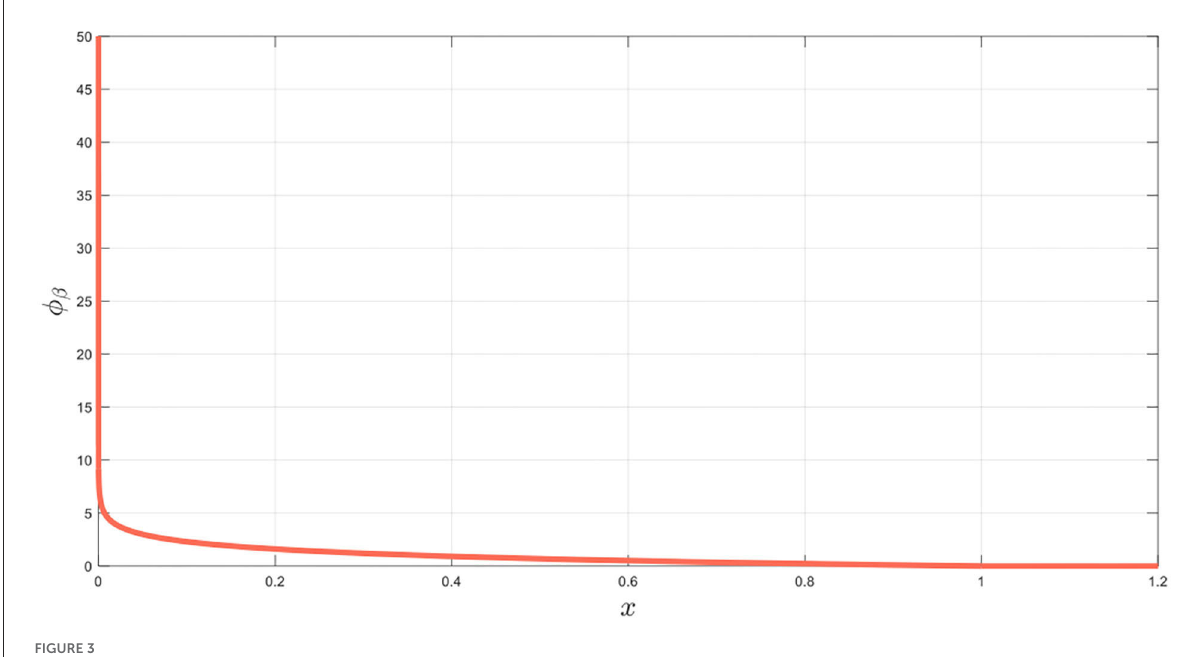
FIGURE3 Repulsive potential function φ ib ( x